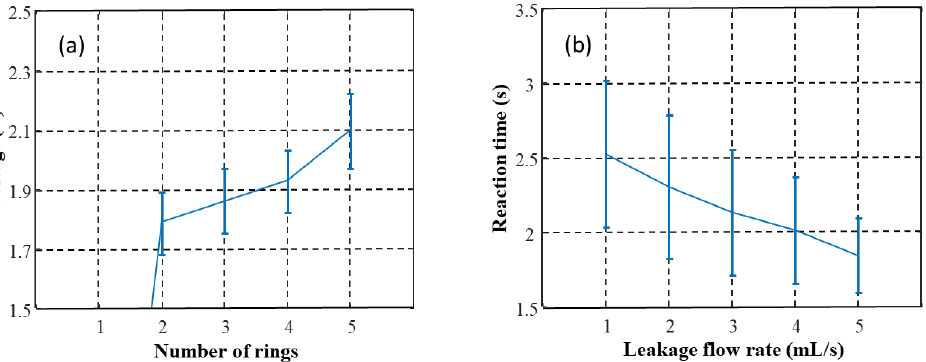
Figure 7. The relationship between the volume of blood leakage and ( a ) the sensor voltage and ( b ) the reaction time of the leakage detection patch, respectively.